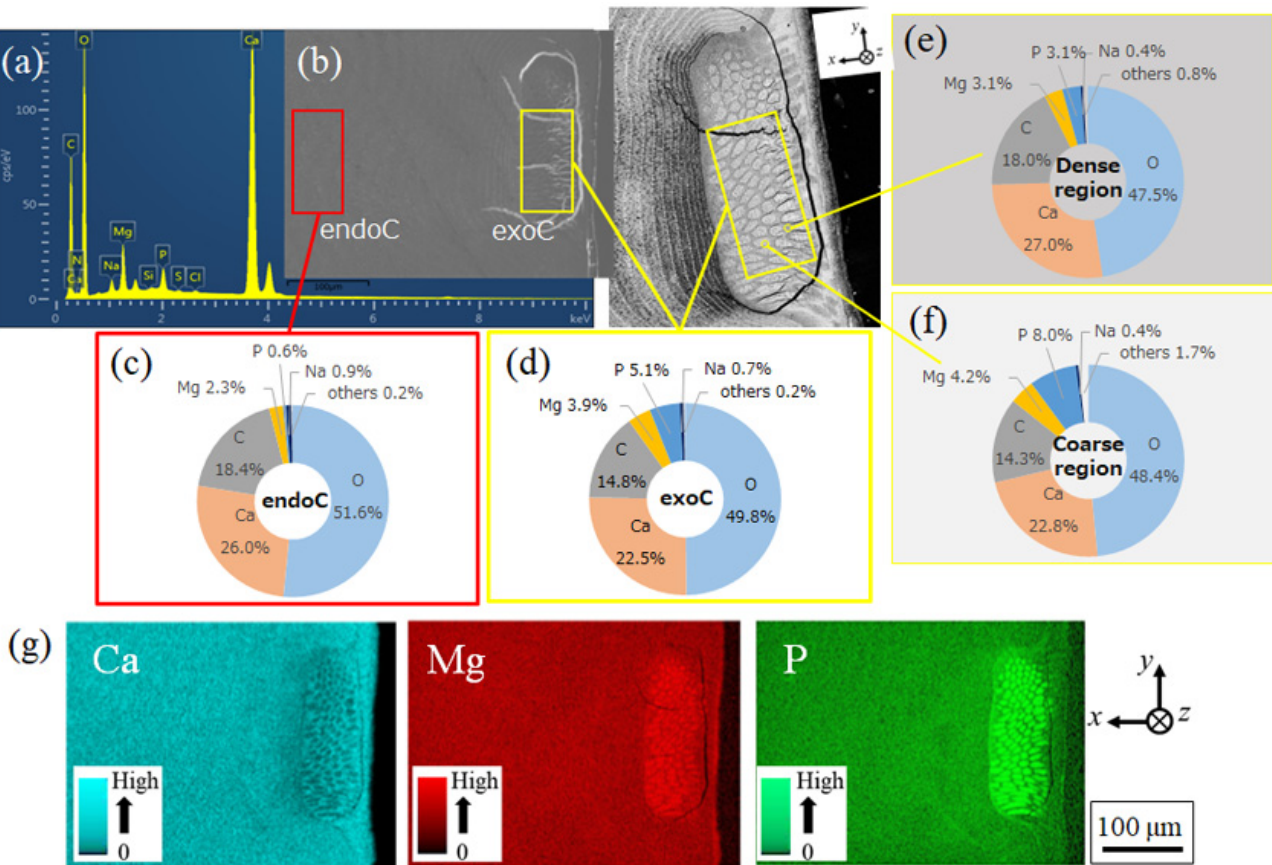
Figure 10. ( a ) X-ray spectrum showing the presence of C, O, Mg, P, Ca, Na, Si, S, N, and Cl. ( b ) SEM image showing the area near the surface, including the exocuticle. ( c – f ) EDS-area scan results for the region surrounded by ( c ) a red rectangle and ( d ) a yellow rectangle in ( b ), and EDS point results for ( e ) the dense region and ( f ) the coarse region. Here, concentrations of C and O were shown as reference data due to sample contamination. ( g ) EDS maps showing the distributions of Ca, Mg, and P.